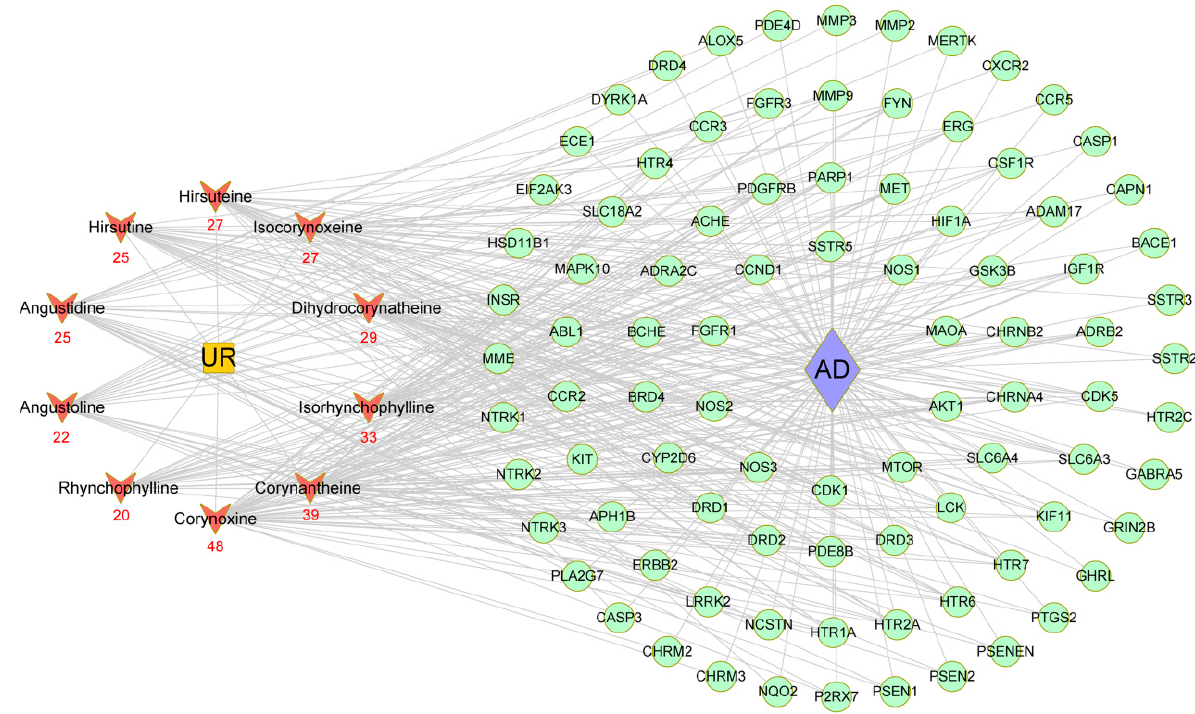
Figure 5. Potential alkaloid target-AD target network. Red nodes represent the main alkaloids extracted from UR, and the numbers beneath each node represent the number of UR targets against AD. Green nodes represent shared targets between potential targets of UR alkaloids and AD targets. UR: Uncaria rhynchophylla ; AD: Alzheimer's disease.